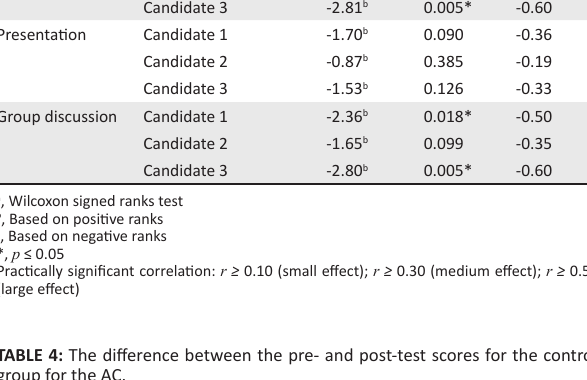
TABLE 4: The difference between the pre- and post-test scores for the control group for the AC. Simulation